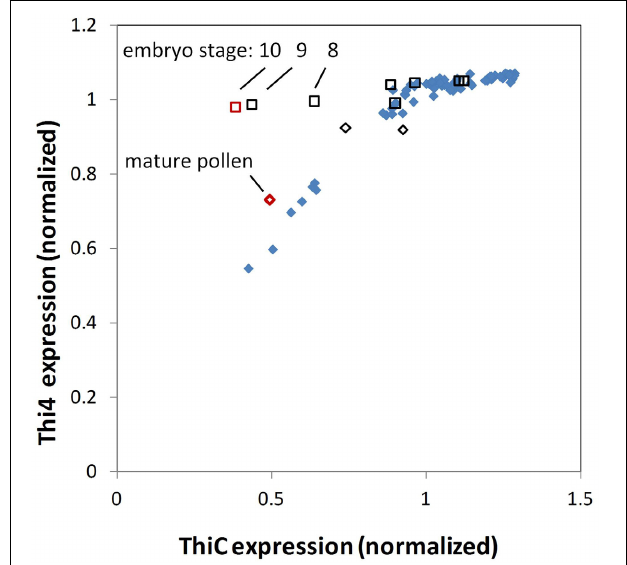
FIGURE 3 | THIC and THI4 expression in Arabidopsis tissues. AtGeneExpress values (log2) for THIC and THI4 were normalized to the respective overall mean of each gene. Relative THI4 expression is strongly correlated with THIC expression except in the later stages of seed development (open squares, red is mature stage) where THIC expression declines sharply during embryo maturation while THI4 expression remains high. Seed at earlier stages (black open squares), stamens containing developing pollen (black open diamonds) and mature pollen (red open diamond) conform to the pattern of proportional expression of THI4 and THIC observed in other tissues (blue solid diamonds).